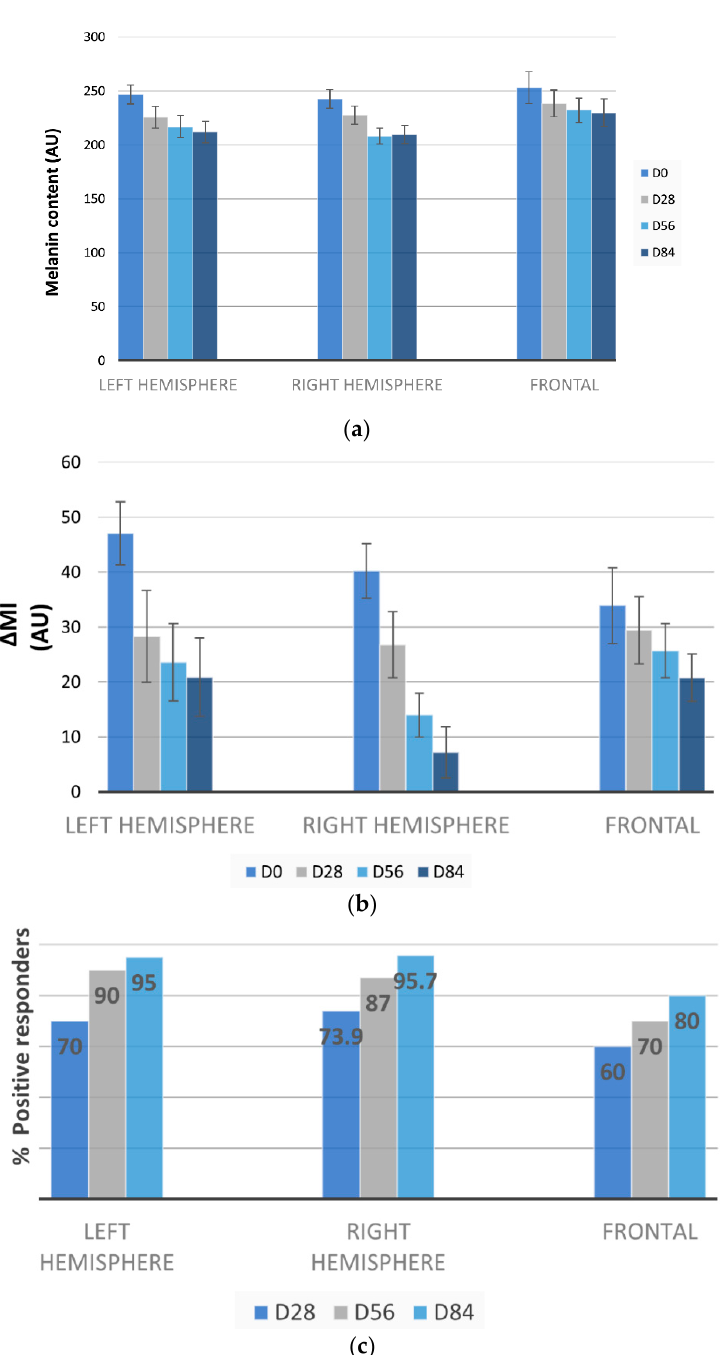
Figure 2. Efficacy of the nutritional (dietary) supplement on different facial regions assessed by Mexameter ® . ( a ) Melanin index of the melasma at different timepoints in the different facial areas; ( b ) ∆ MI represents the difference between the values of melanin index obtained in the area of melasma and the ones obtained in adjacent areas; ( c ) Percentage of subjects responding positively to the treatment.